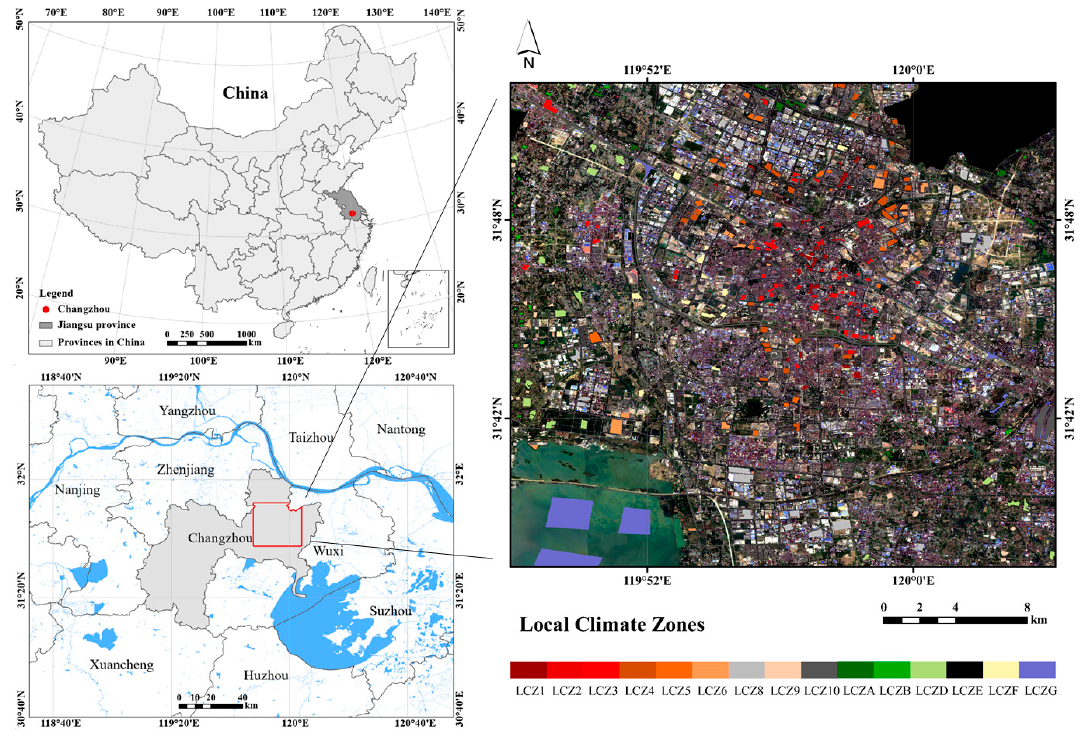
Figure 2. Study area and reference data sampled from Google Earth.